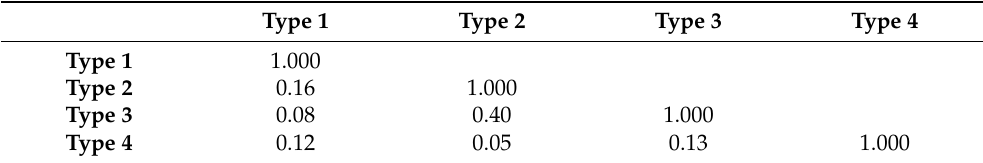
Table 4. Correlations between